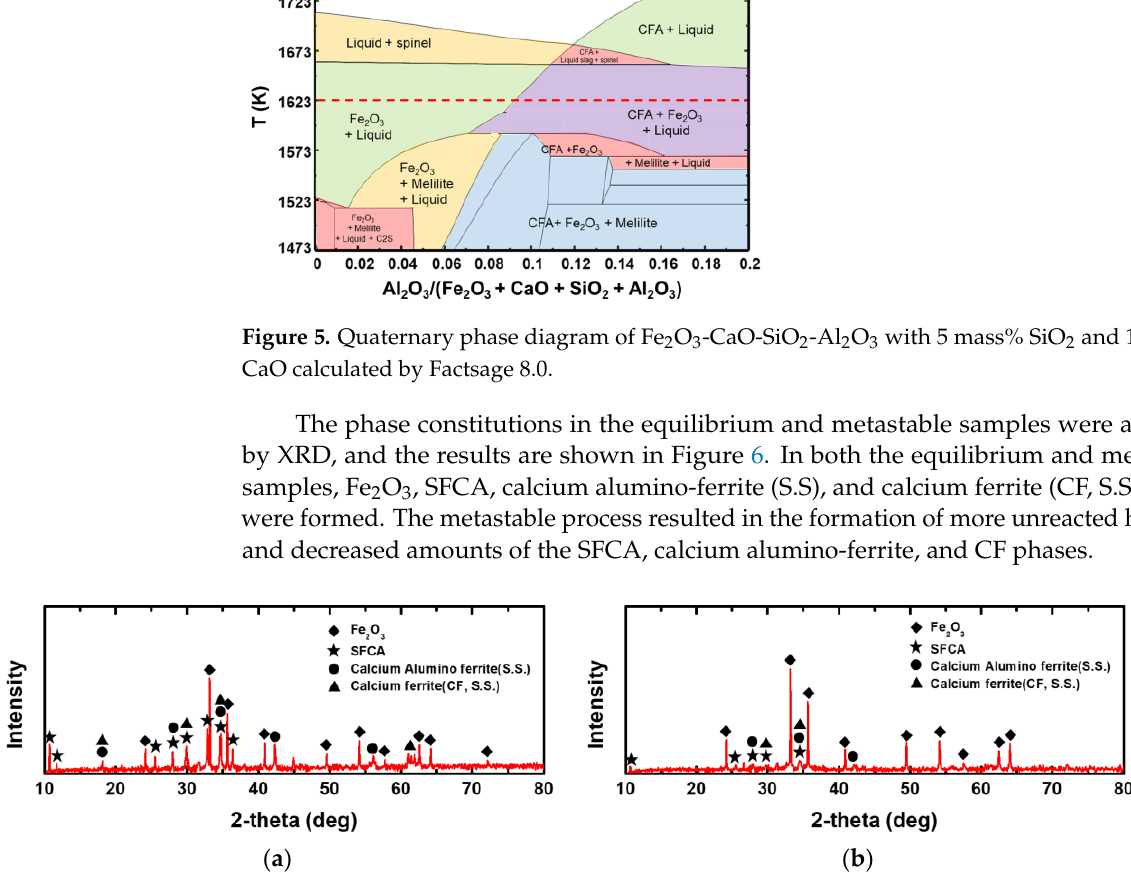
Figure 6. XRD analysis of Fe 2 O 3 -CaO-SiO 2 -10 mass% Al 2 O 3 compacts before reduction: ( a ) equilibrium sample, ( b ) metastable sample.